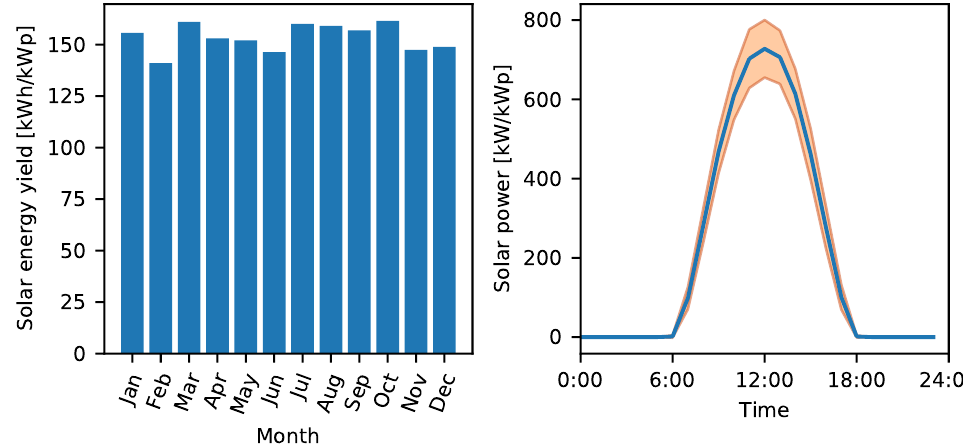
Figure 7. Monthly solar energy yield at the microgrid site ( left ) with mean daily power curve and its standard deviation ( right ).